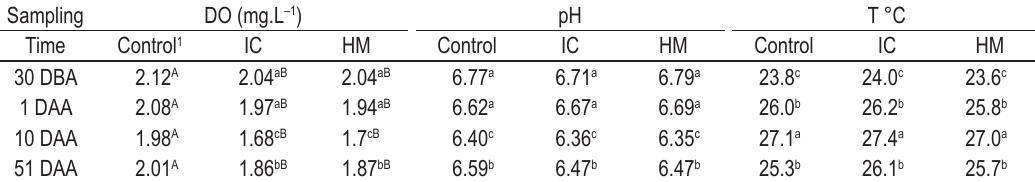
Table 1. Levels of dissolved oxygen (DO), pH, and temperature (T °C) of the rice paddy water at each sampling time, Santa Maria, Rio Grande do Sul, Brazil, 2006. Sampling